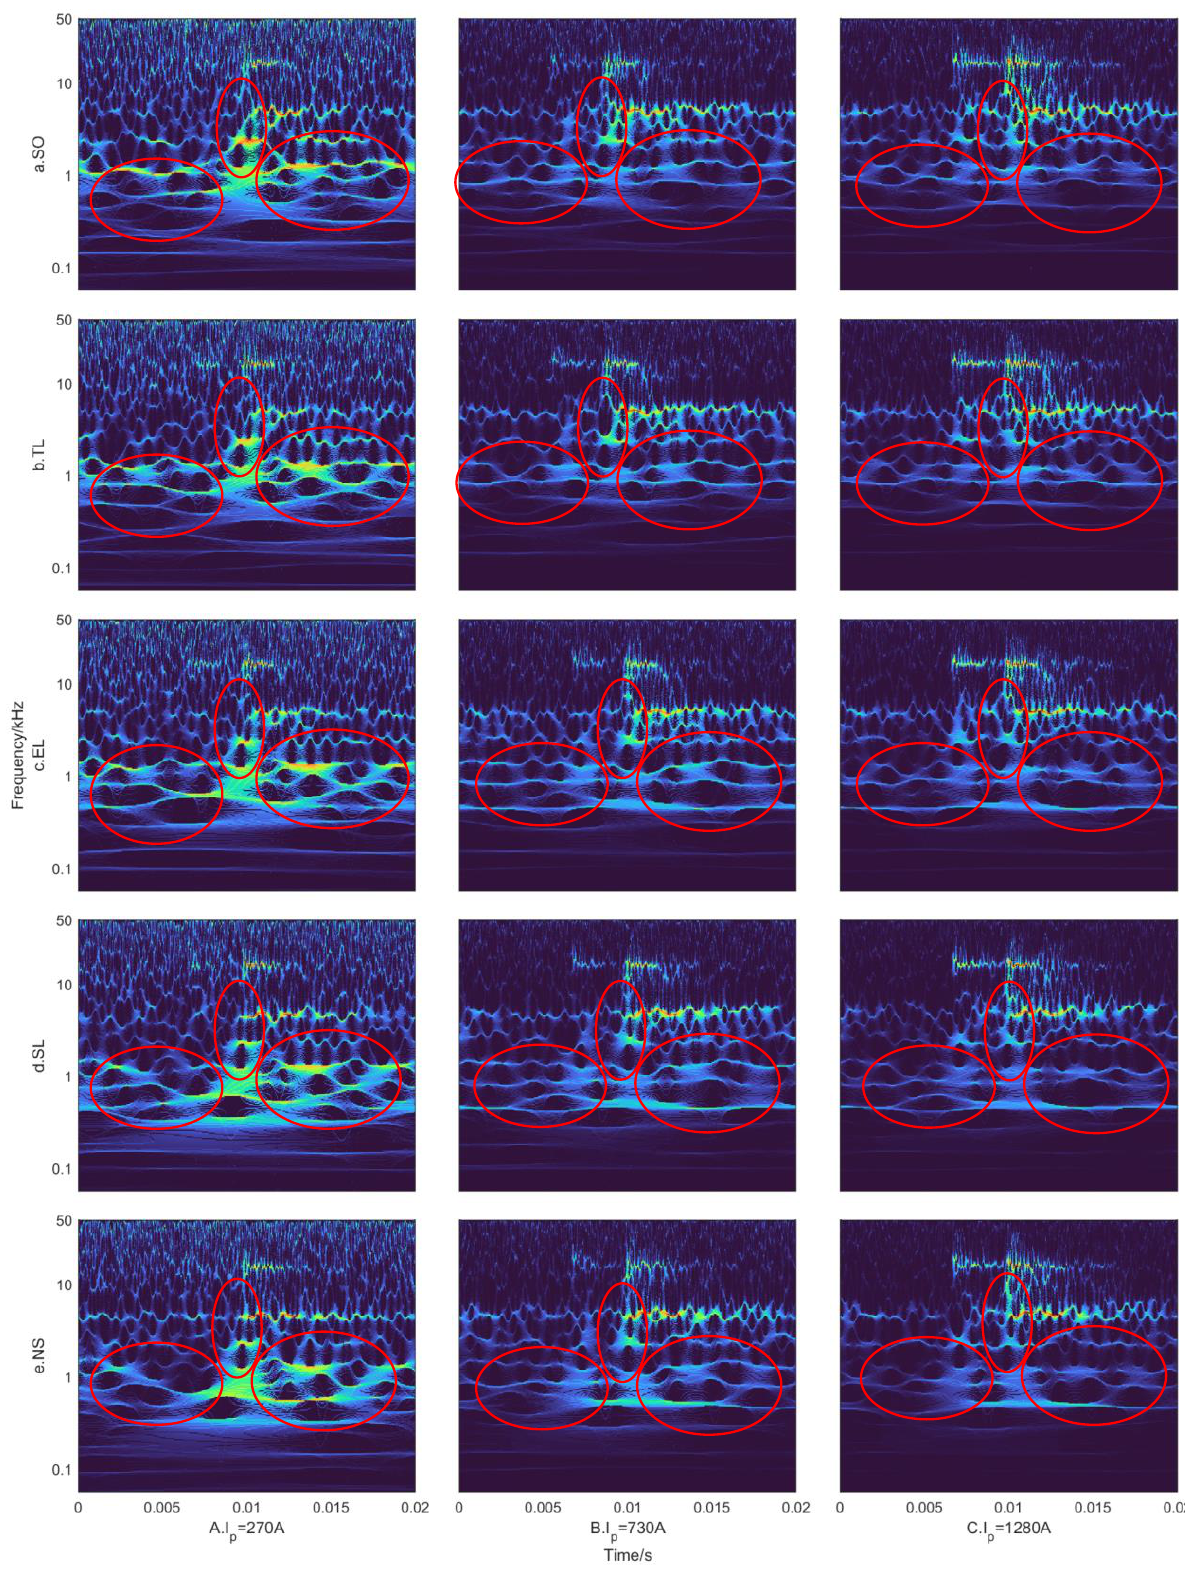
Figure 11. SST time-frequency spectra extracted from samples of different faults and loads. From top to bottom, a~e represent the five iron core looseness faults in Table 4. From left to right, A, B, and C represent that the current peak values are 270 A, 730 A, and 1280 A, respectively.